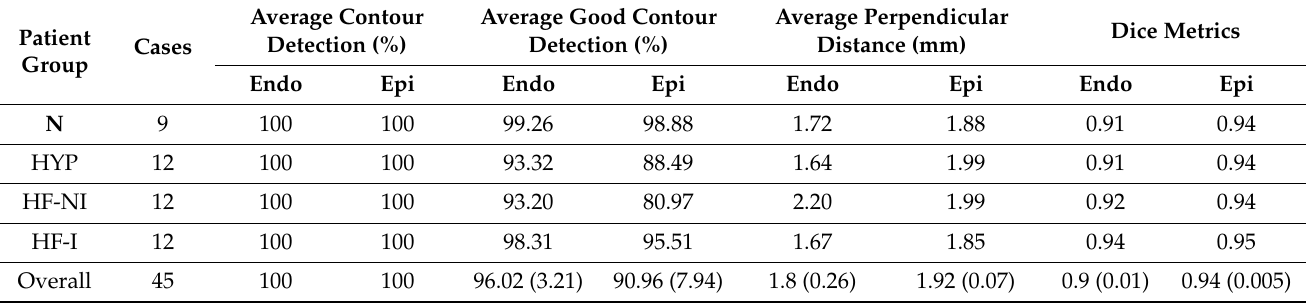
Table 13. Performance evaluation parameters for binary cross-entropy loss and Elu activation.